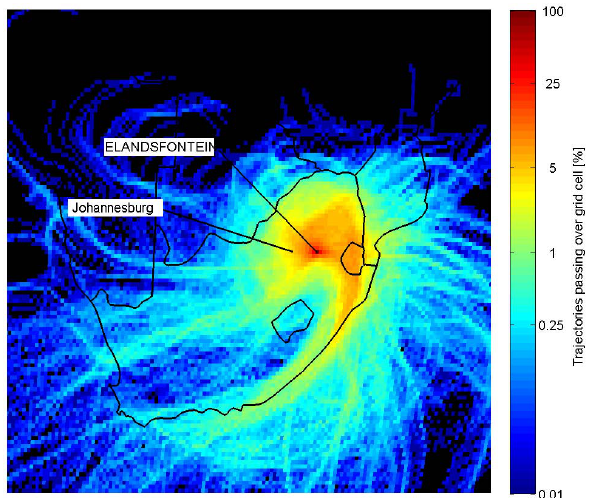
Fig. 1. Overlay back trajectory plot showing the percentage of tra- jectories arriving at Elandsfontein passing over specific areas for the period 11 February 2009–31 January 2011. HYSPLIT 96-h back trajectories (Draxler and Hess, 2004) for the observational period of this paper.